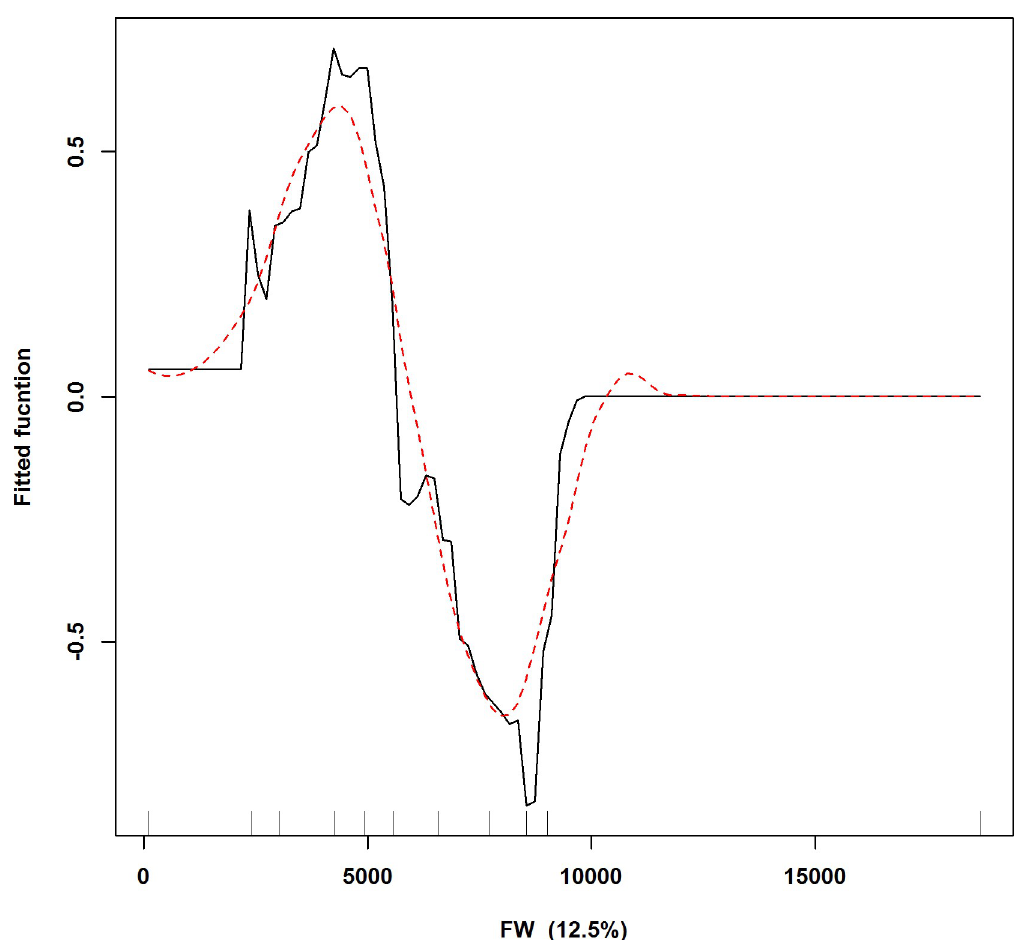
Fig 2. Fitted functions produced by boosted regression trees of collision potentials for buzzards at wind turbine structures depicting the marginal effect of collision possibility (y-axes) by each DELV. Contribution of each DELV is given in brackets. Rug plots show distribution of the data across distances of DELV’s in meters and are used as a measure of confidence across the shapes of the fitted functions. Signs denoting (+) are distances outside the edge of the land use variables and (-) are distances inside the edge of the land use